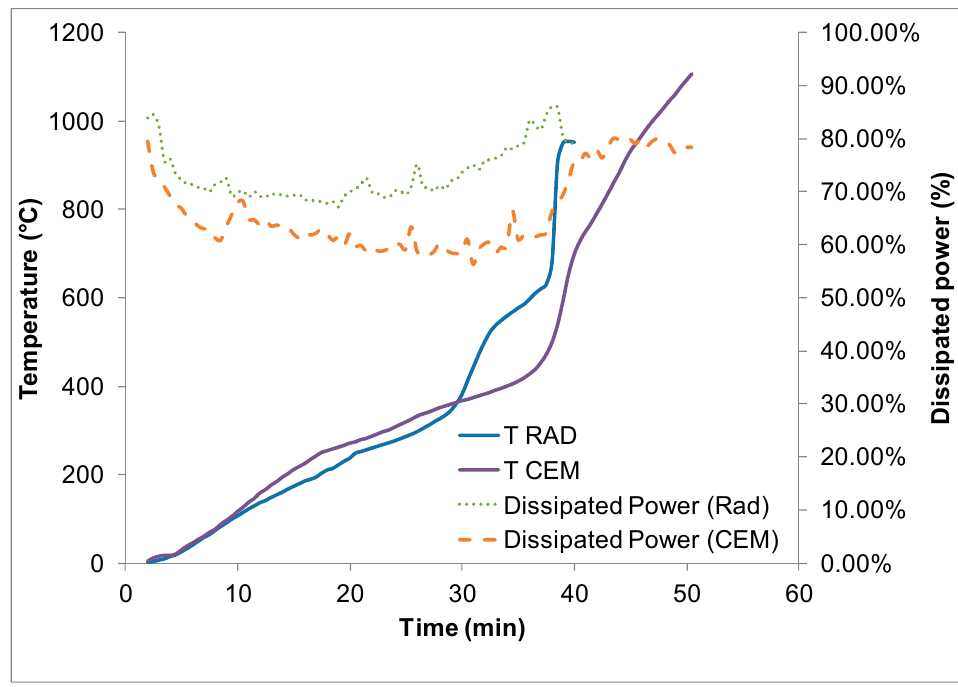
Figure 2. Heating curve (T prefix) and dissipated power of the load obtained from 10 g of precursors, 600 W forward power, microwave-heated in multi-mode applicators (CEM and Radatherm) operating at 2.45 GHz.